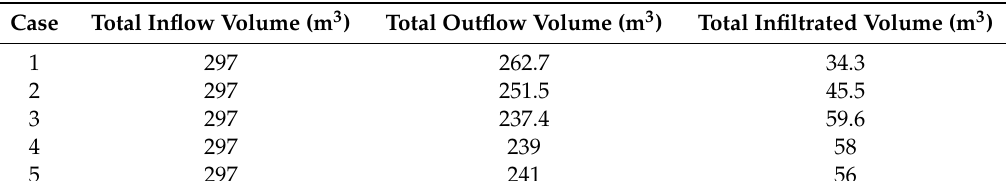
Figure 11. The values of cumulative infiltration F for different times for the five check dam design